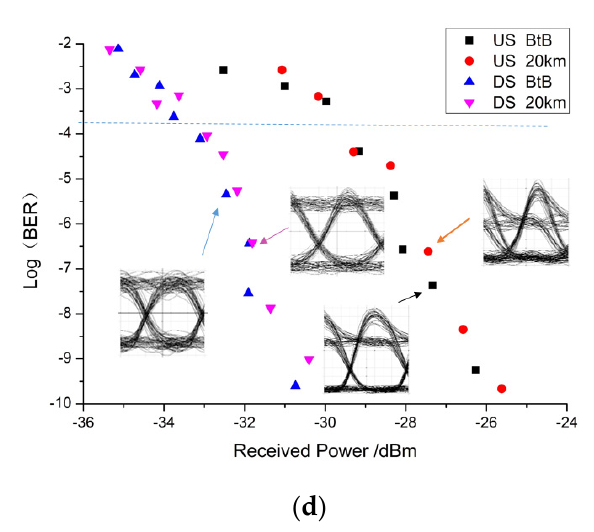
Figure 3. The BER against the received power in a 10 Gb/s unidirectional transmission: ( a ) the upstream (US) BER curves for input power (Pi) values; ( b ) the US BER curves for the peak − to − peak RF voltage (V PP ) values; ( c ) the US BER curves for the bias current (I bias ) values; ( d ) the US and downstream (DS) BER curves for back − to − back (BtB) and 20 km fibers.